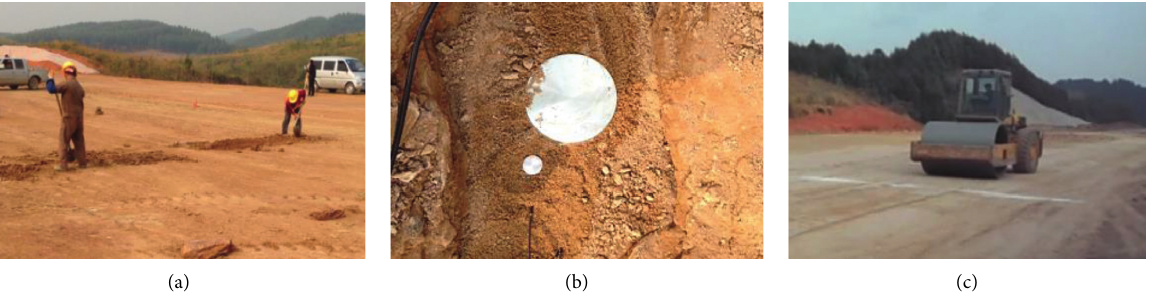
Figure 4: Implementation process of burying sensors layer by layer: (a) excavation groove, (b) embedding of sensors, and (c) compaction of the top surface of the